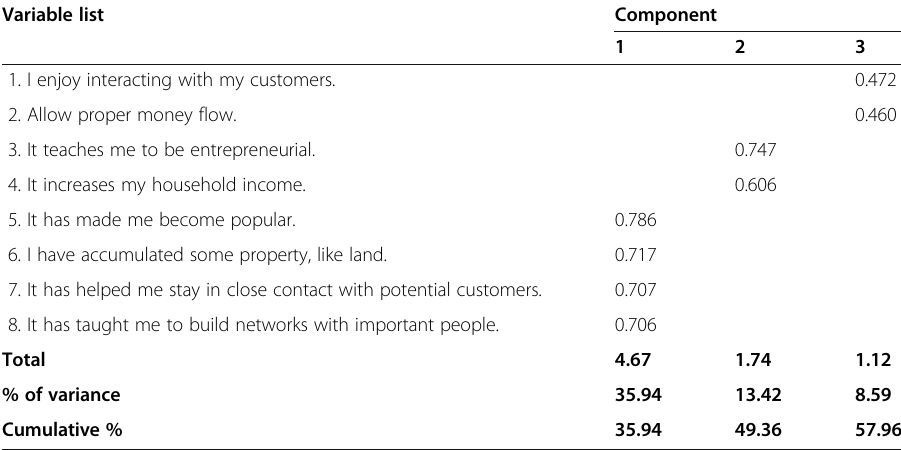
Table 2 Factor analysis on the contribution to the growth of SMEs Variable list